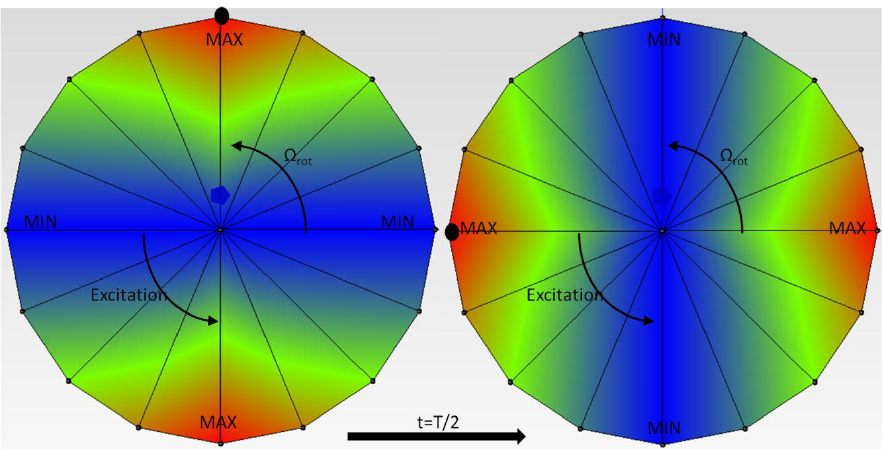
Figure 4. = +2 pressure pulsations for a rotating